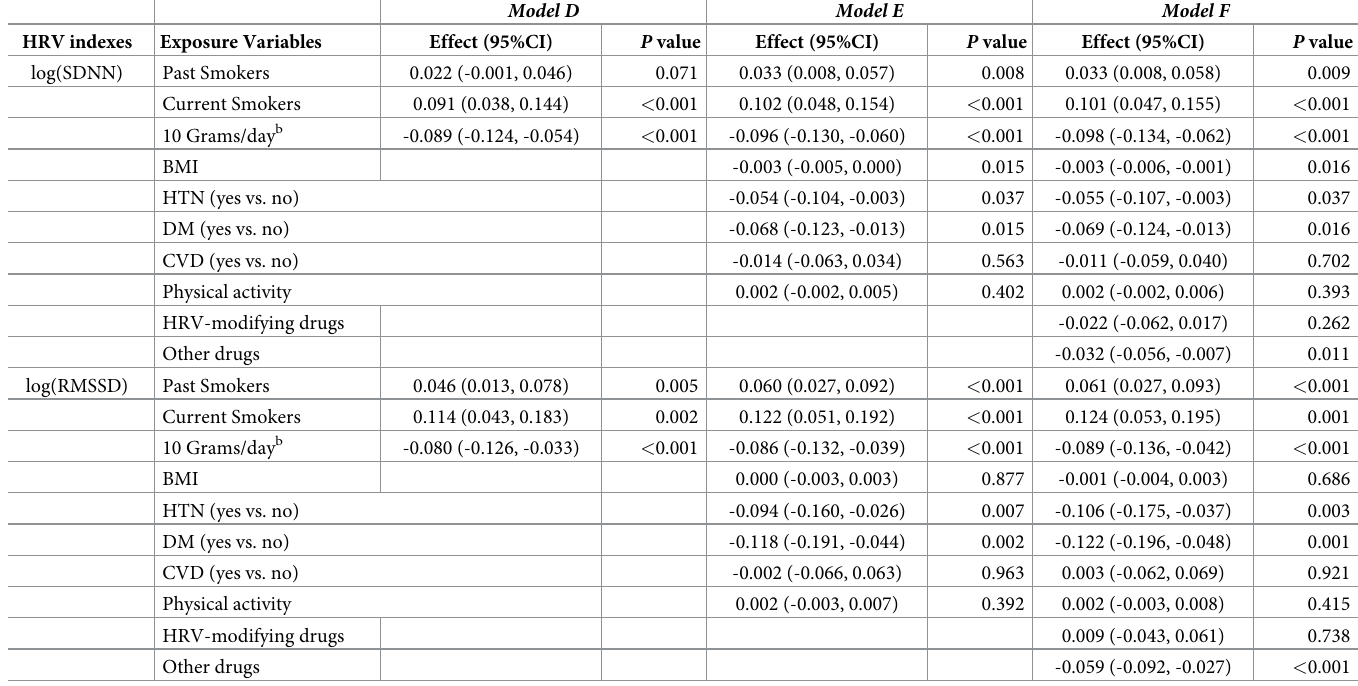
Table 4. Association of HRV time-domain indexes with smoking status and intensity (model D); smoking status, smoking intensity and cardiometabolic risk factors (model E); and smoking status, smoking intensity, cardiometabolic risk factors, and drugs (model F) a